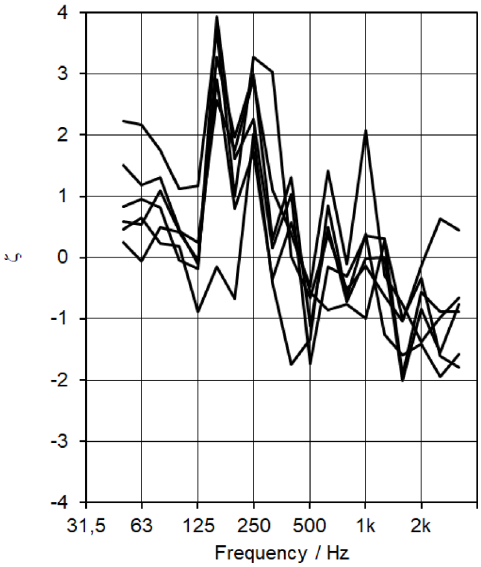
Figure 21. Test quantity for the consistency